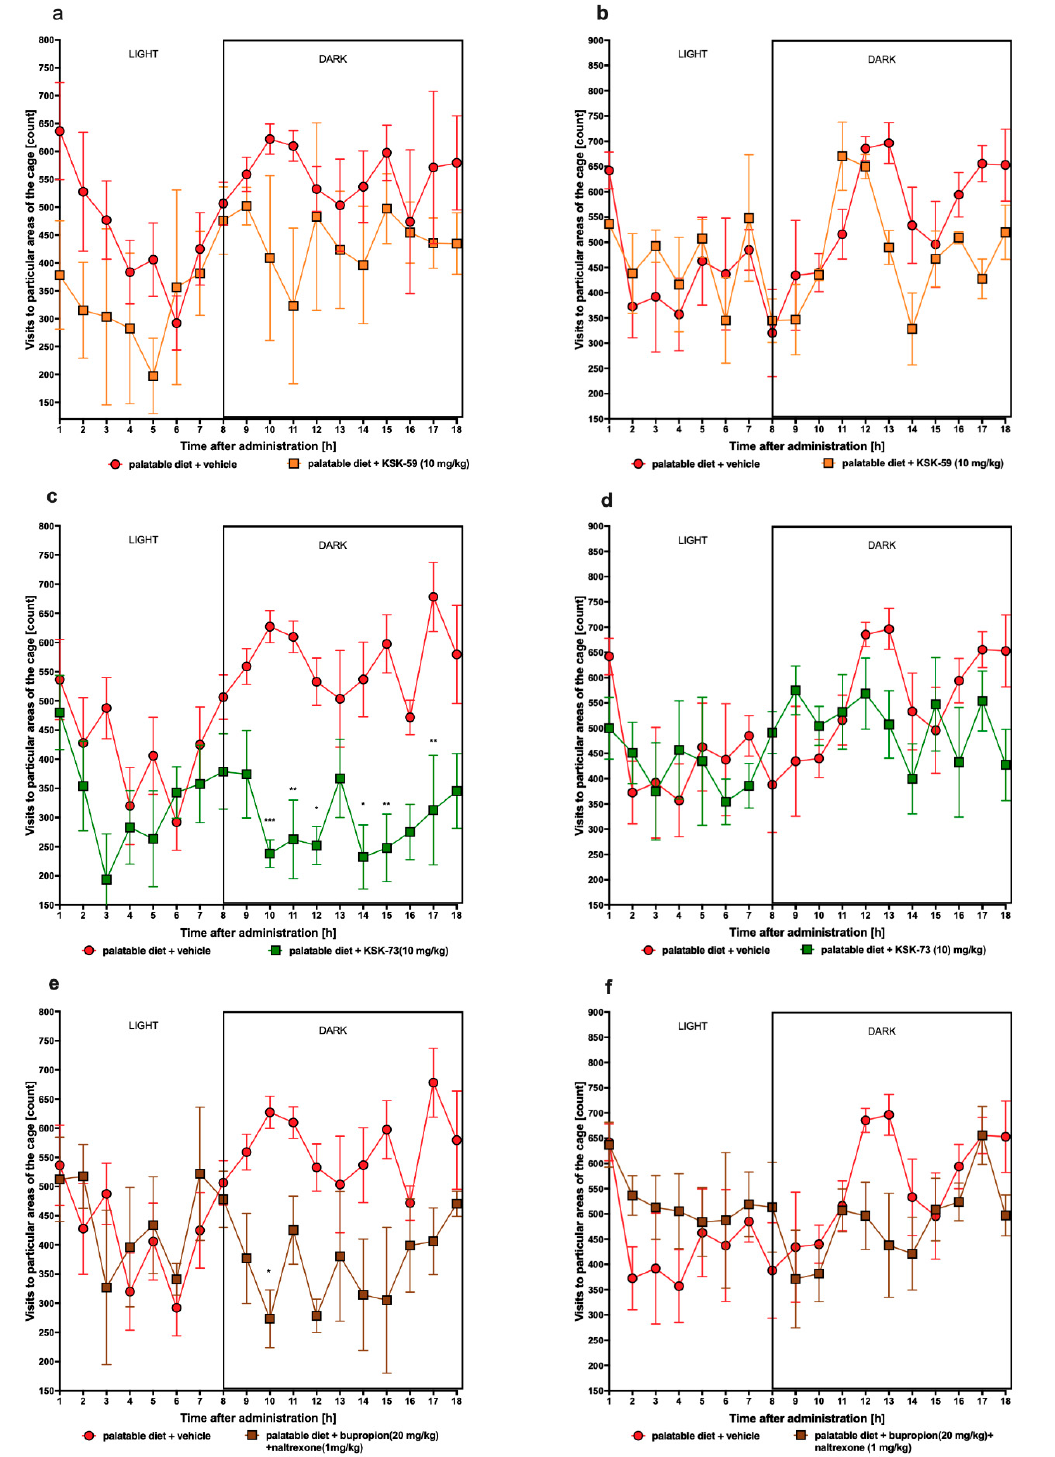
Figure 9. Spontaneous activity after the 1st and 27th administration of the tested compounds. Results are expressed as means ± SEM, n = 6. Comparisons were performed by two-way ANOVA, Bonferroni’s post hoc tests; ( a ) control group fed palatable diet and after 1st administration of KSK-59; ( b ) control group fed palatable diet and after 27th administration of KSK-59; ( c ) control group fed palatable diet and after 1st administration of KSK-73; ( d ) control group fed palatable diet and after 27th administration of KSK-73; ( e ) control group fed palatable diet and after 1st administration of bupropion/naltrexone; ( f ) control group fed palatable diet and after 27th administration of bupropion/naltrexone; * p < 0.05, ** p < 0.01, *** p <